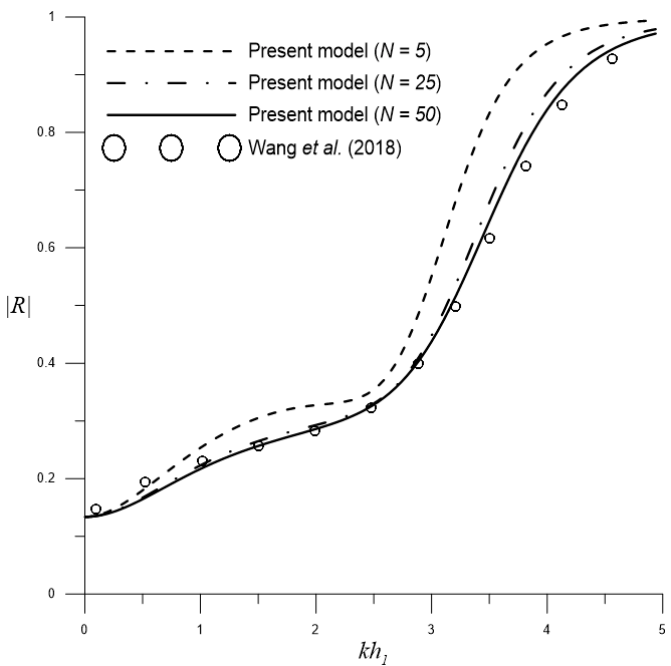
| | R Figure 5. Reflection coefficient | R | varying against kh 1 for the case of parallel surface-piercing barriers Figure 5. Reflection coefficient varying against 1 kh for the case of parallel surface ‐ piercing over the step-type bottom. barriers over the step ‐ type bottom.